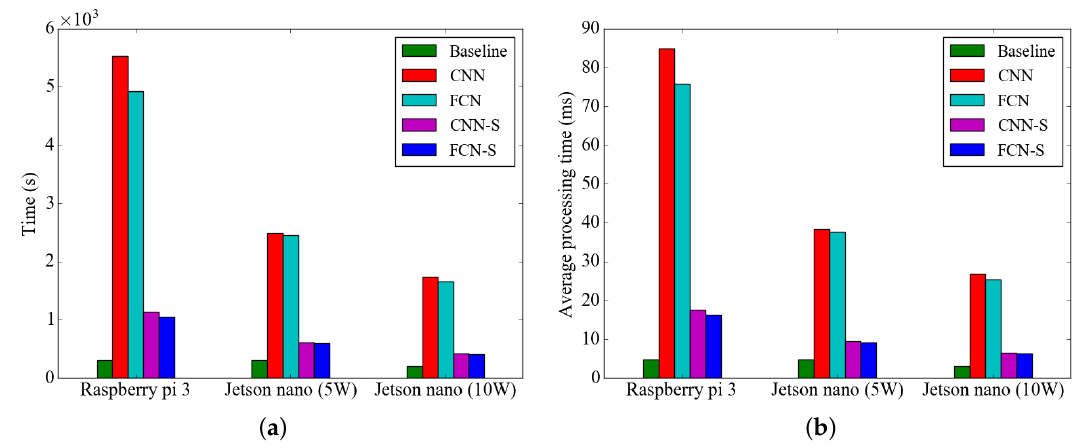
Figure 10. Processing time of activity recognition methods on embedded platforms ( a ) Total processing time ( b ) Average processing time per